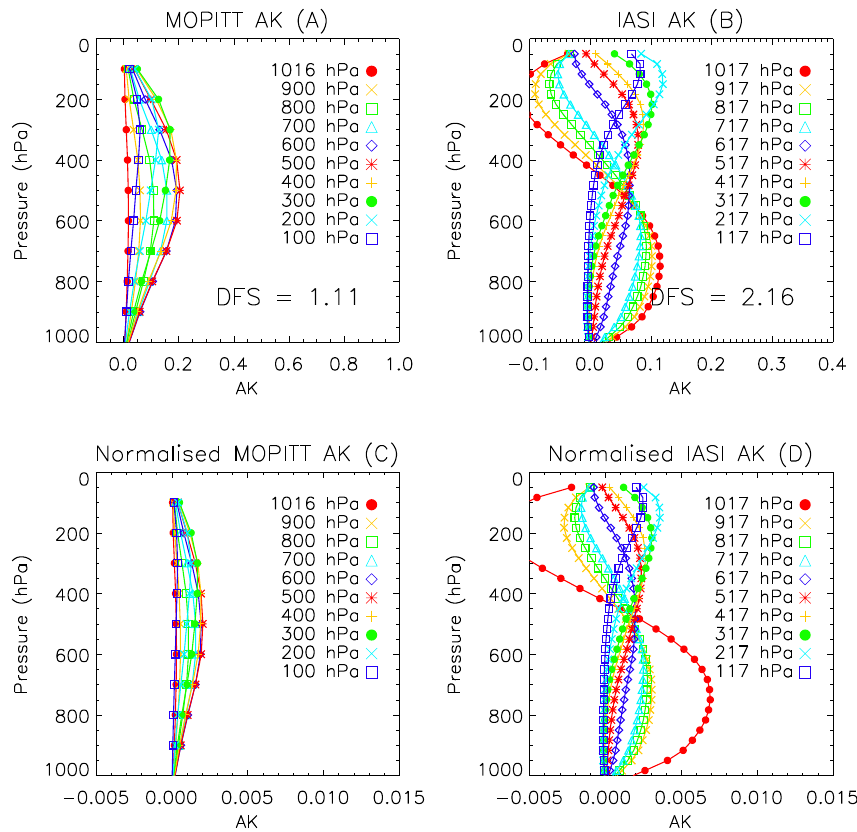
Fig. 6. Daytime and ocean averaging kernels over the Southern Africa region for 1 September 2007, for: (A) MOPITT V4 ( A MOP4 ) at MOPITT V4 pressure levels, (B) IASI ( A IASI ) at the IASI pressure levels closest to the MOPITT V4 pressure levels, (C) pressure-layer- normalised averaging kernels for MOPITT V4 ( A MOP4 ), and (D) pressure-layer-normalised averaging kernels for IASI ( A IASI N the pressure-layer-normalised averaging kernels are hPa − 1 .